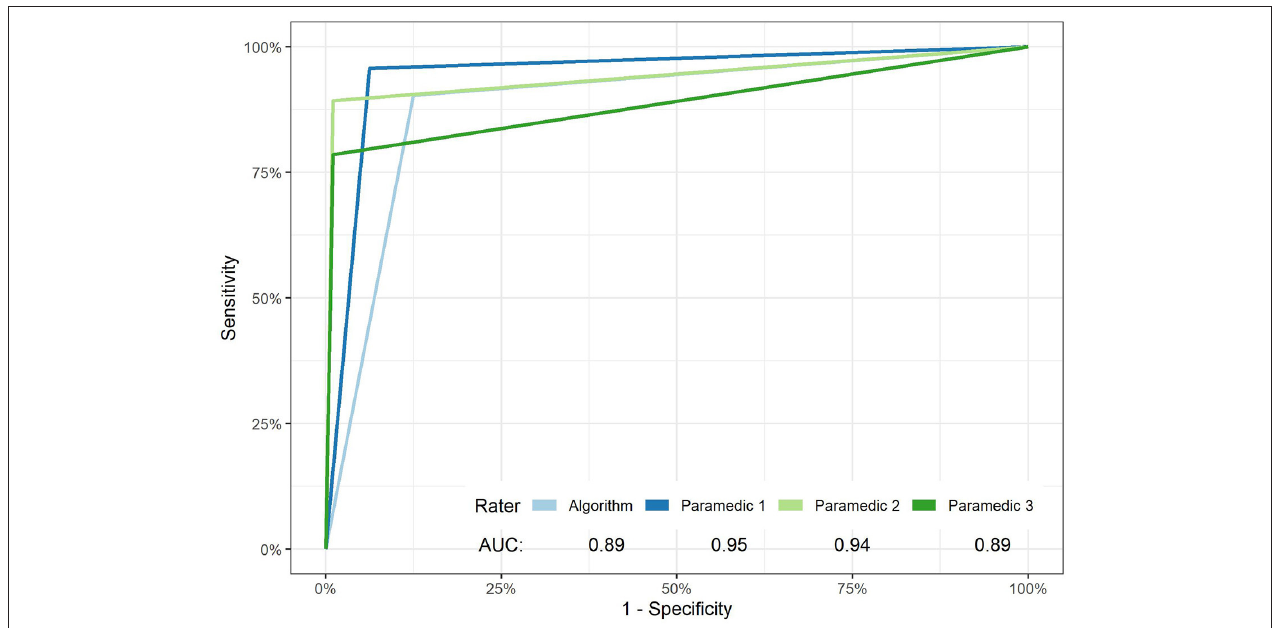
FIGURE 2 | ROC curves of facial weakness and laterality detection of the algorithm and each paramedic. The overall performance of paramedics vs. the algorithm in the detection of unilateral facial weakness failed to reach significance ( p -value 0.074).